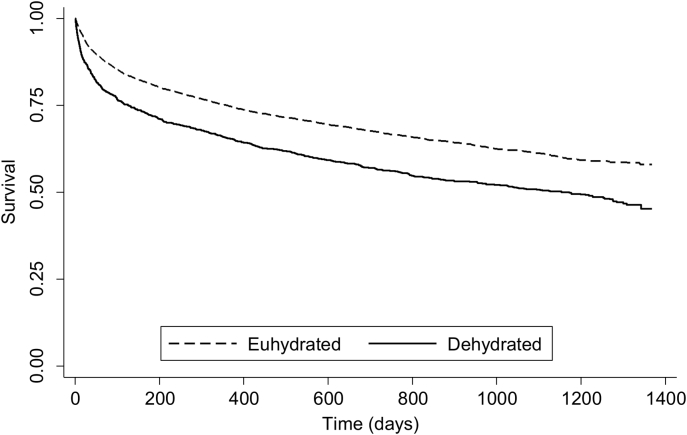
Kaplan-Meier survival plot demonstrating the relationship between hydration status and mortality (P < 0.001). Dehydrated indicates hyperosmolar dehydration.